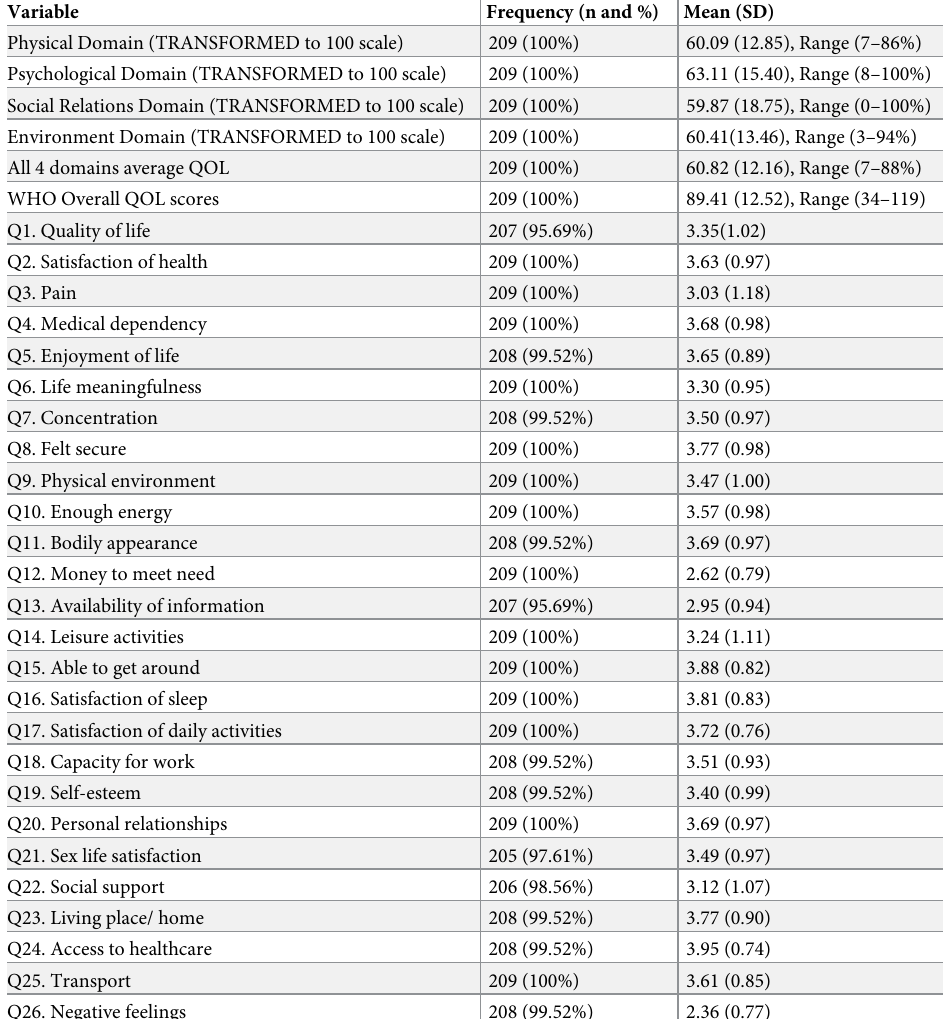
Table 1. WHO-BREF QOL scores of the respondents.